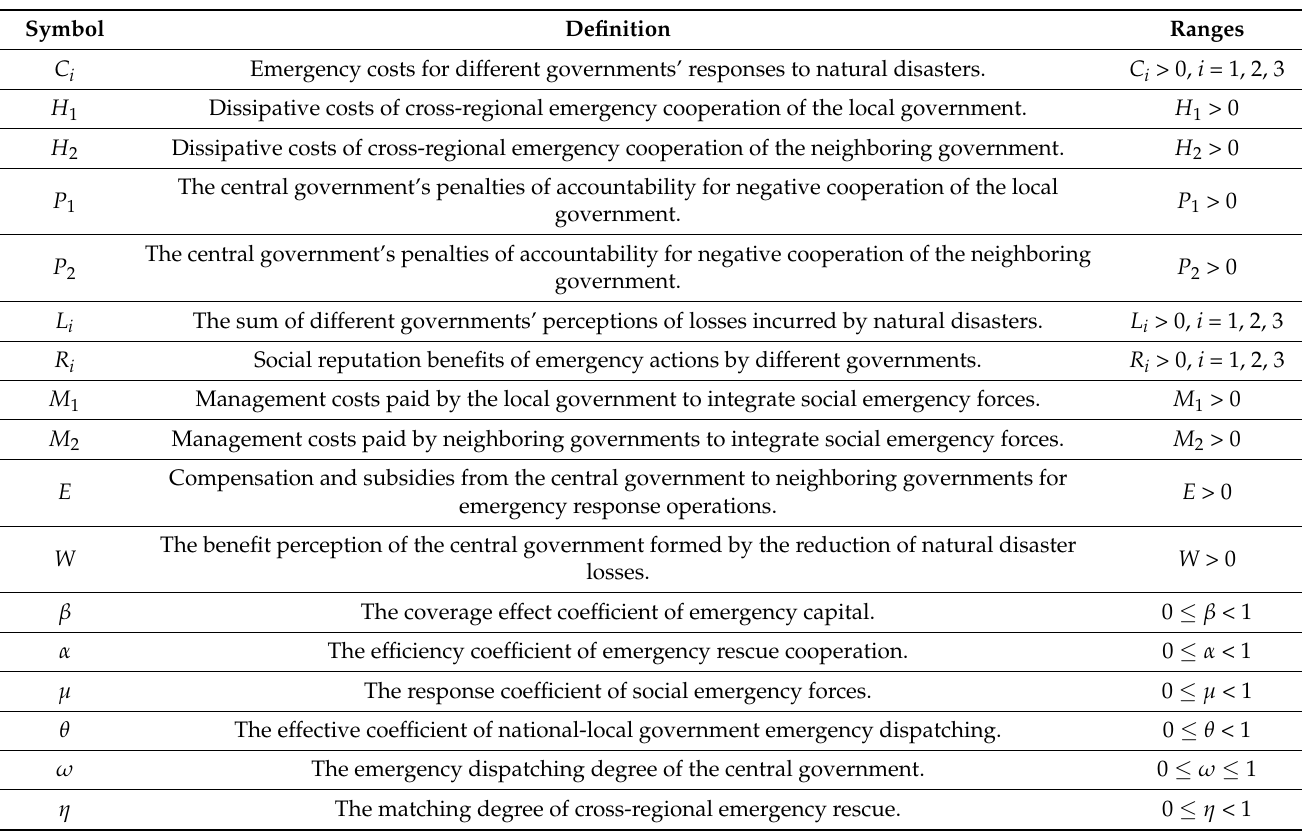
Table 1. Definition of